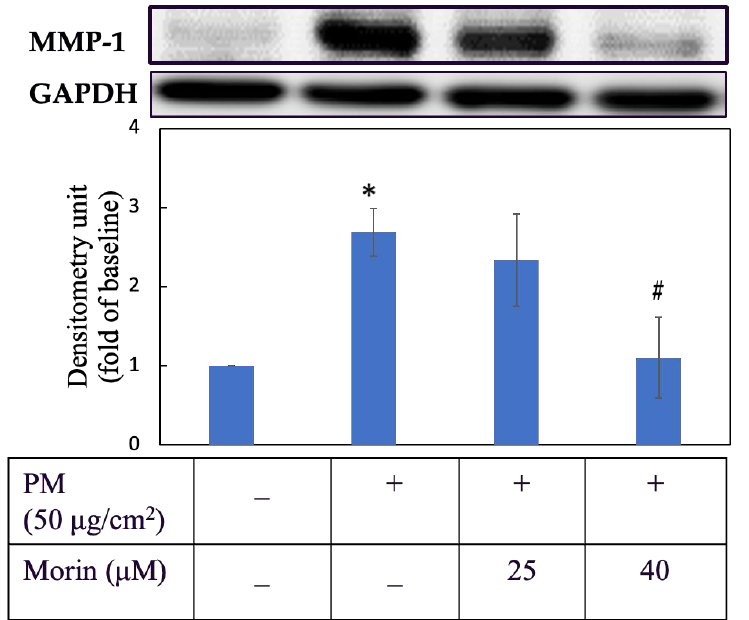
Figure 5. MMP-1 protein expression. Cells were pre-incubated with morin for 3 h and then treated with PM for 6 h. +, − mean with or without exposing to PM or morin, respectively. Data were presented as mean ± SD and from triplicate experiments. *, # indicates a statistically significant difference with control group (without treating PM and morin) and PM group (only treating PM), p <